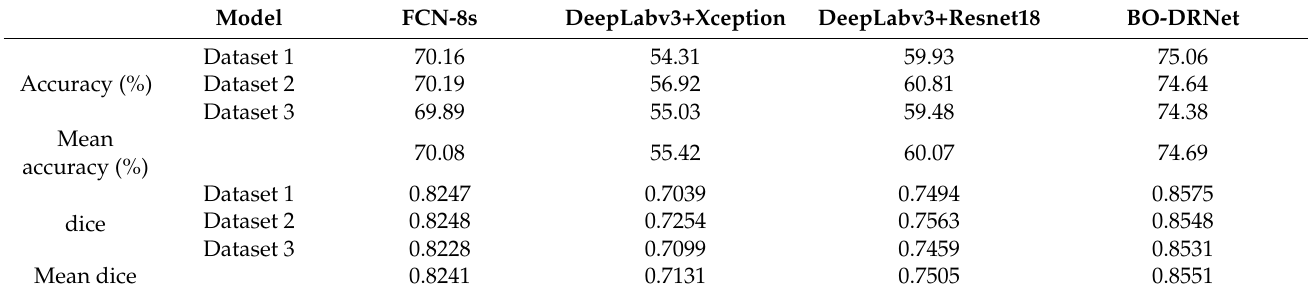
Table 5. The experimental results of four deep learning models for three datasets.